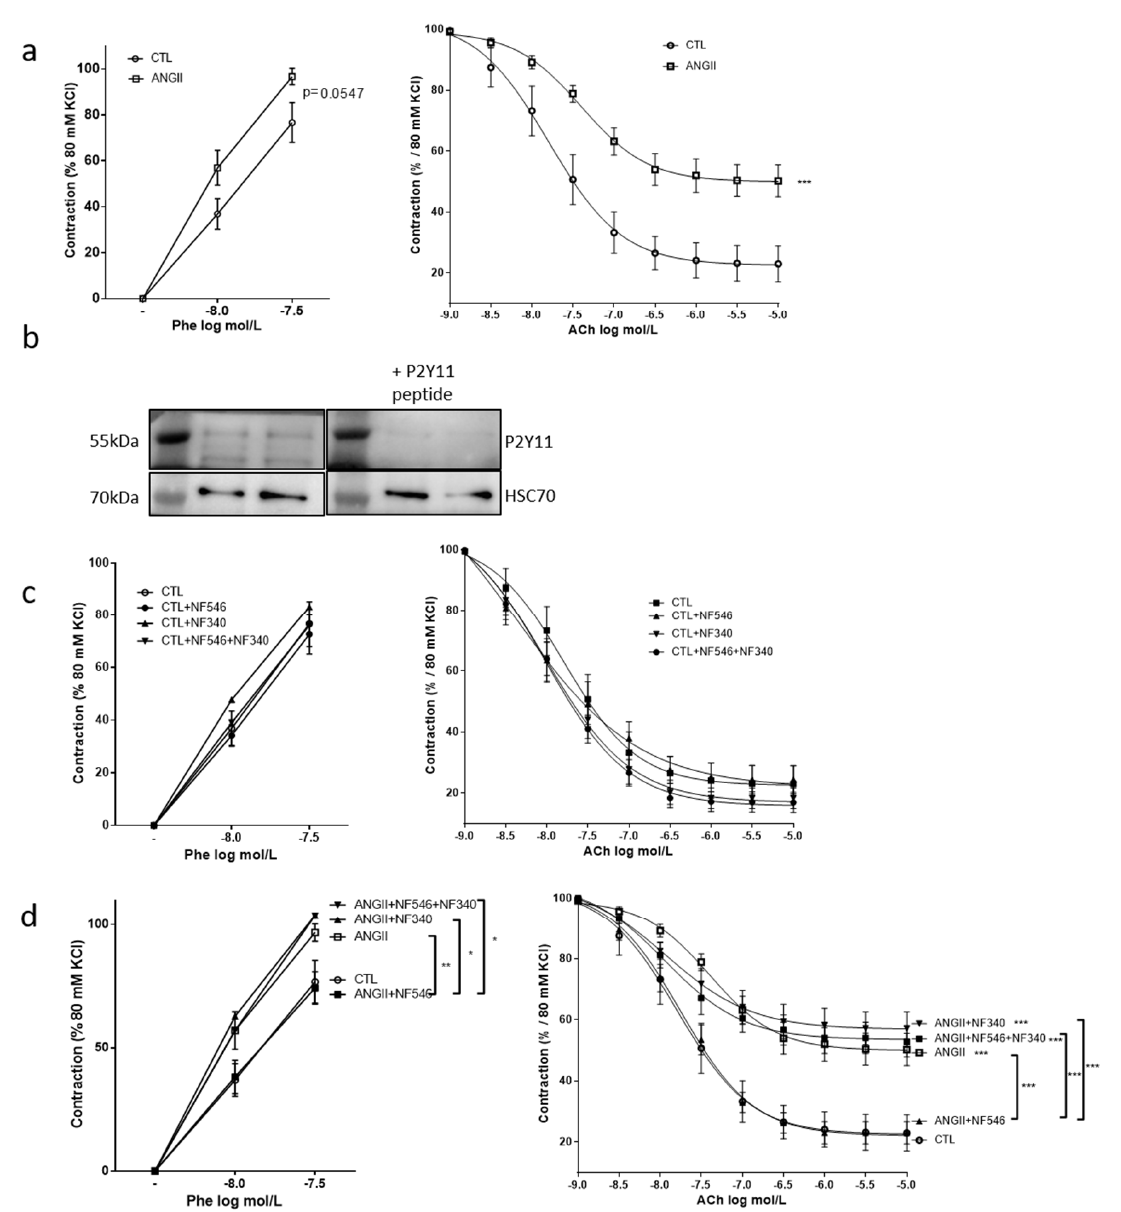
Figure 1. The P2Y11 agonist NF546 restores vascular function impaired by angiotensin II stimulation. Rat aortic rings were incubated 30min with or without angiotensin II (AngII) (100 nM), NF546 (10 µ M), or NF340 (10 µ M), then vasomotor response was evaluated in response to increasing concentrations of phenylephrine (Phe) (1.10 − 8 M–5.10 − 7 M) and acetylcholine (Ach) (1.10 − 9 M–1.10 − 5 M). ( a ) AngII tended to increase the vasoconstrictive response to Phe ( p = 0.0547) and significantly reduced ( p < 0.001,) vasorelaxation in response to Ach compared to the control (CTL) (n = 12). ( b ) Expression of a P2Y11-like protein was analyzed by western blot on aortic rings lysate. A band at 55 and 35 kDa could be immunodetected using anti-hP2Y11 primary antibody, and this was prevented by the use of hP2Y11 peptide (n = 2). ( c ) In the CTL group, NF546 or NF340 P2Y11 ligands did not show any significant effects on vascular tone (n = 12). ( d ) In the AngII-treated group, the P2Y11 agonist NF546 significantly restored basal vasomotor response, while the P2Y11 antagonist NF340 had no effect when used alone, but abolished the effect of NF546 when co-applied (n = 12). * p < 0.05, ** p < 0.01 and *** p < 0.001, compared to CTL condition if not